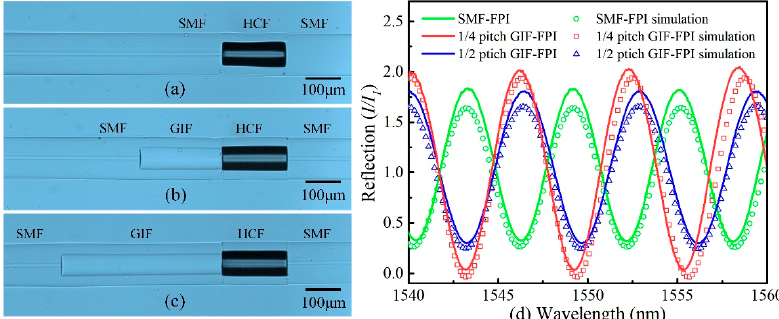
Figure 4. ( a – c ) Microscope images of an SMF FPI, a quarter-pitch (245 μ m) GIF-FPI, and a half-pitch (490 μ m) GIF-FPI with the same FPI cavity length of ~200 μ m, respectively. ( d ) Measured and (490 µ m) GIF-FPI with the same FPI cavity length of ~200 µ m, respectively. ( d ) Measured and simulated reflection spectra of the SMF-FPI, a quarter-pitch GIF-FPI, and a half-pitch GIF-FPI. (Simulation parameters: ∆ = 0.02, r = 31.25 µ m, ω 0 = 5 µ m (in SMF), λ = 1550 nm and n 0 = 1.491, R = 0.04, L 1 = 199.6, 191.8, and 198.8 µ m respectively, for a SMF-FPI, a quarter-pitch GIF-FPI and a half-pitch